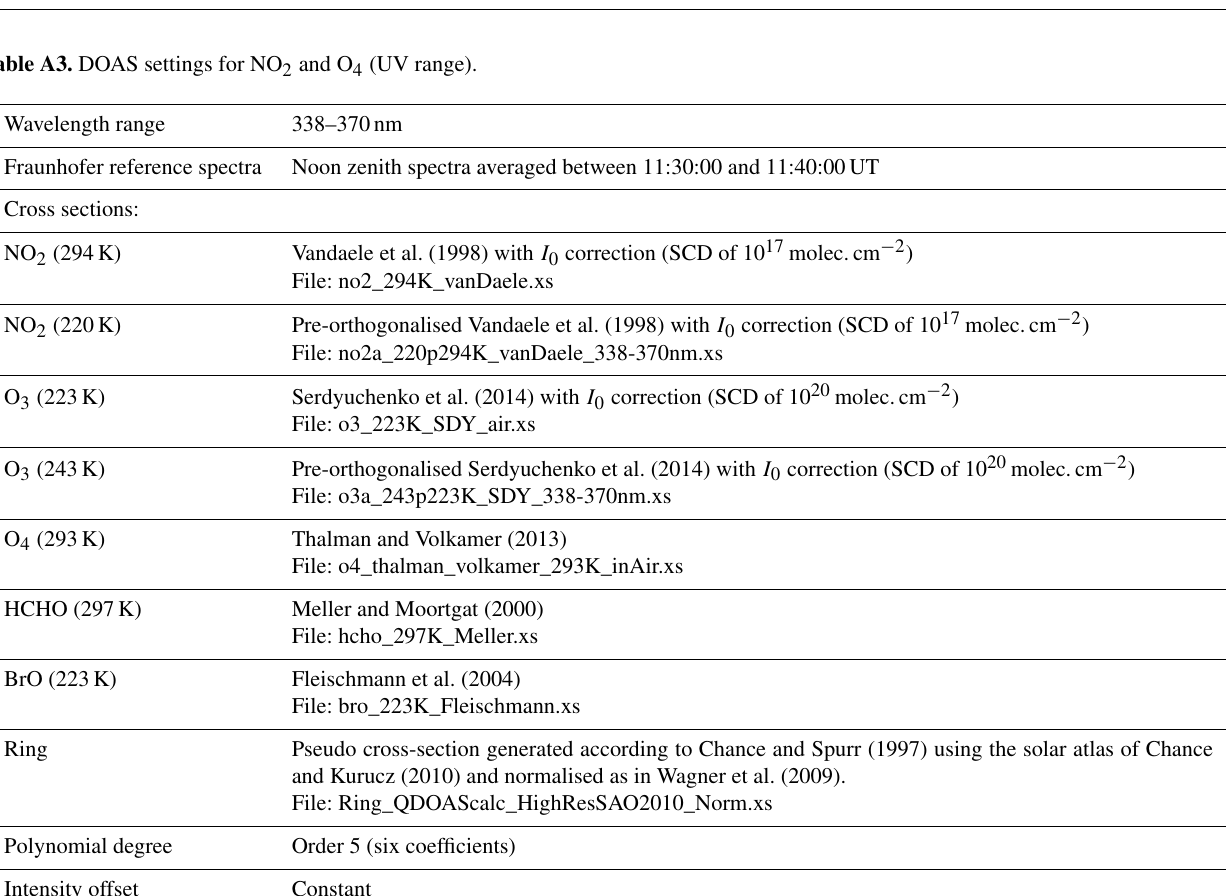
Table A3. DOAS settings for NO 2 and O 4 (UV range). Wavelength